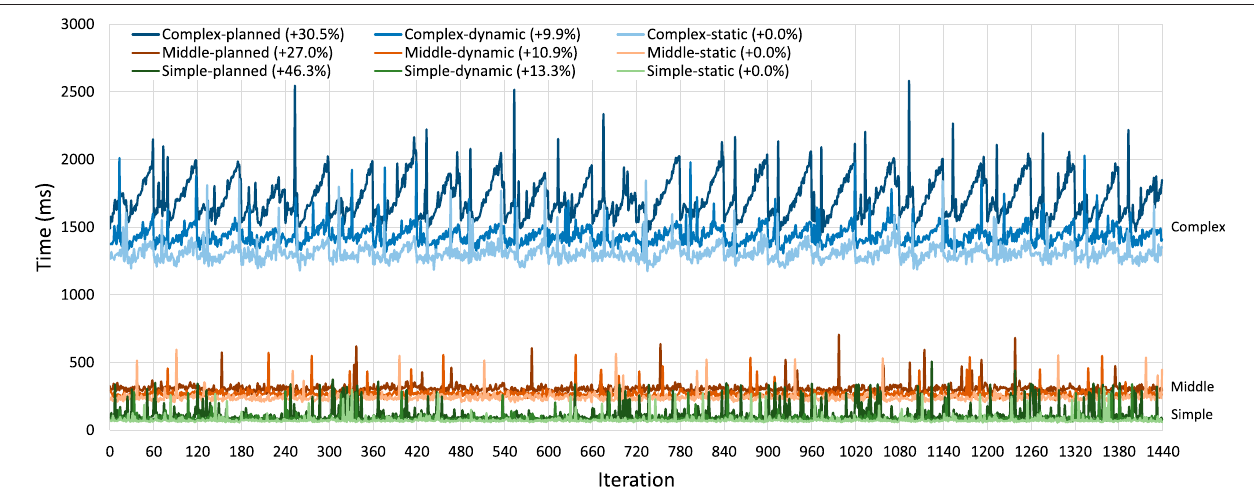
FIGURE 8 | Results of the runtime overhead experiment per scenario. Each scenario is given a color, with the lightest, the mild, and darkest shades of each color representing the static , the dynamic , and the planned implementations, respectively. The vertical lines indicate 60 pipeline iterations, after which the Spark application is restarted.